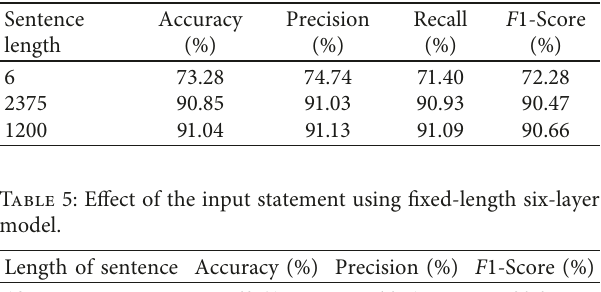
Table 4: Effect of the input statement using fixed-length dataset II.